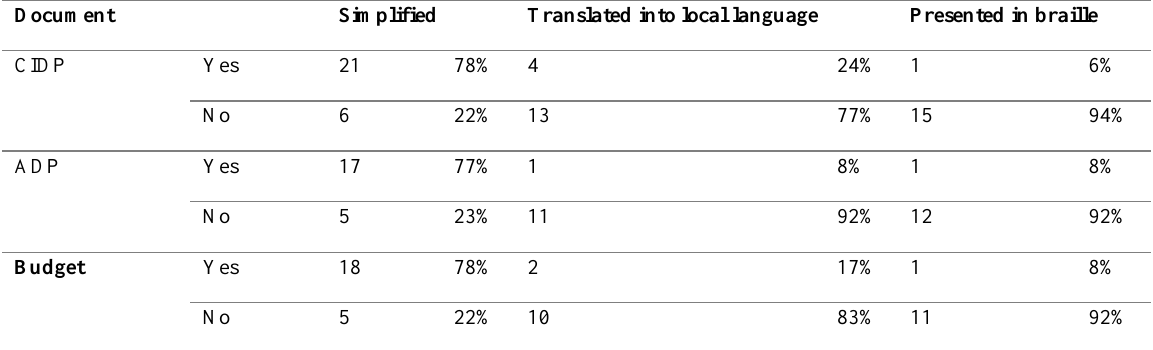
Table 8: County document status